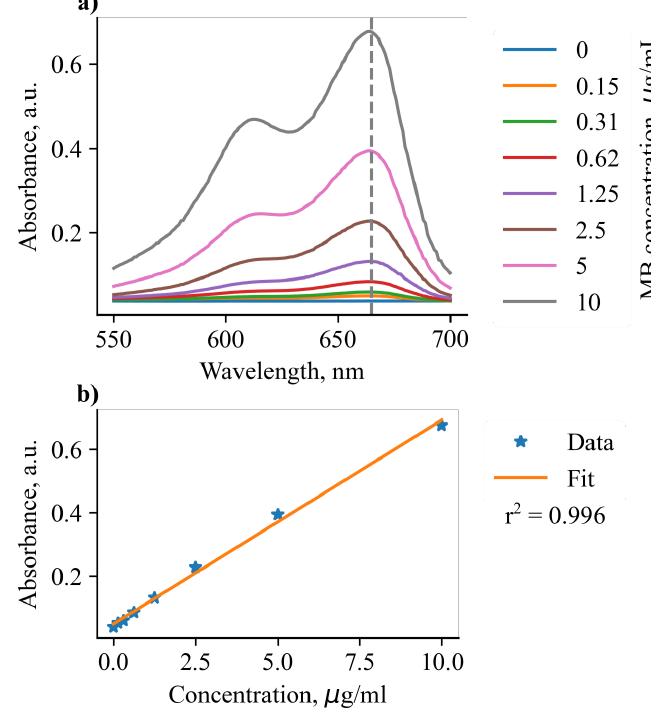
Figure A2. ( a ) Absorption spectra of MB at different concentrations. Gray dashed line indicates the absorption maximum located at 665 nm. ( b ) Linear calibration curve for the MB dye. Absorption values are acquired at 665 nm. Fit equation is A [ a . u . ] = 0.064 ∗ Conc [ µ g/mL] +